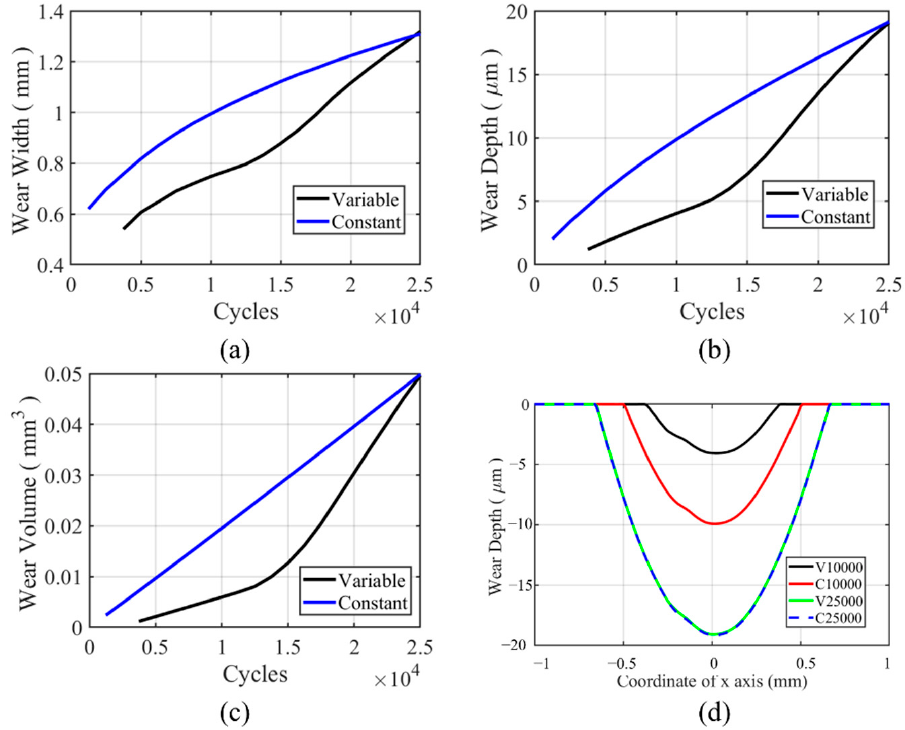
Figure 16. History and profile of wear characteristics for the flat specimen in the gross sliding regime for both CWCM and VWCM: ( a – c ) are the history of wear characteristics, and ( d ) is the wear profiles after 10,000th and 25,000th cycle.